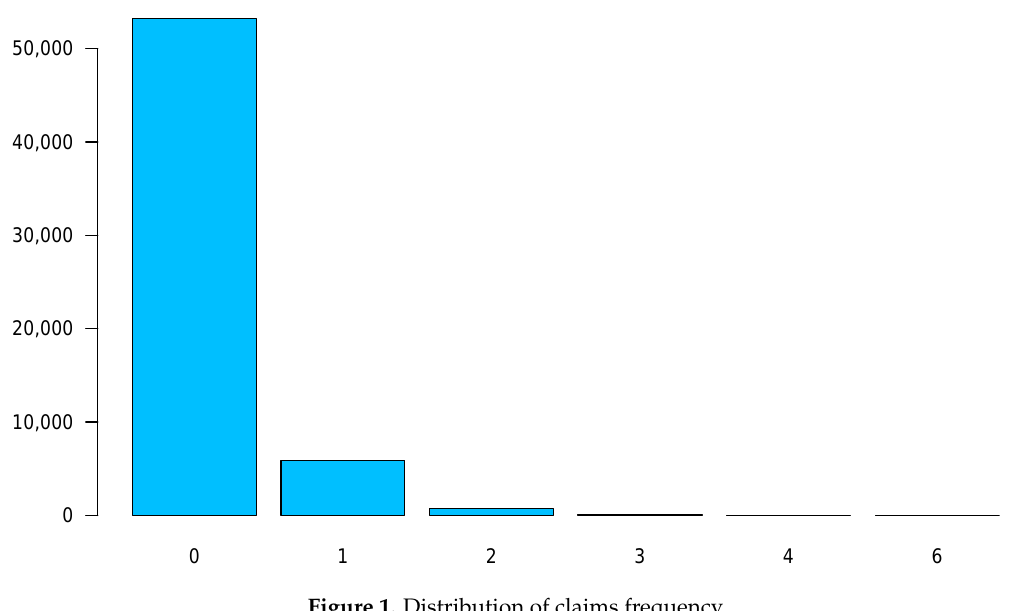
Figure 1. Distribution of claims